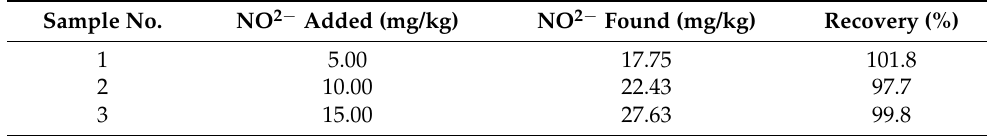
Table 1. Recovery studies of the proposed sensor in sausage samples. Sample